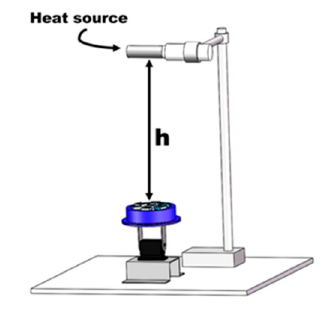
Figure 20. Schematic diagram of the test VSICE experimental platform.